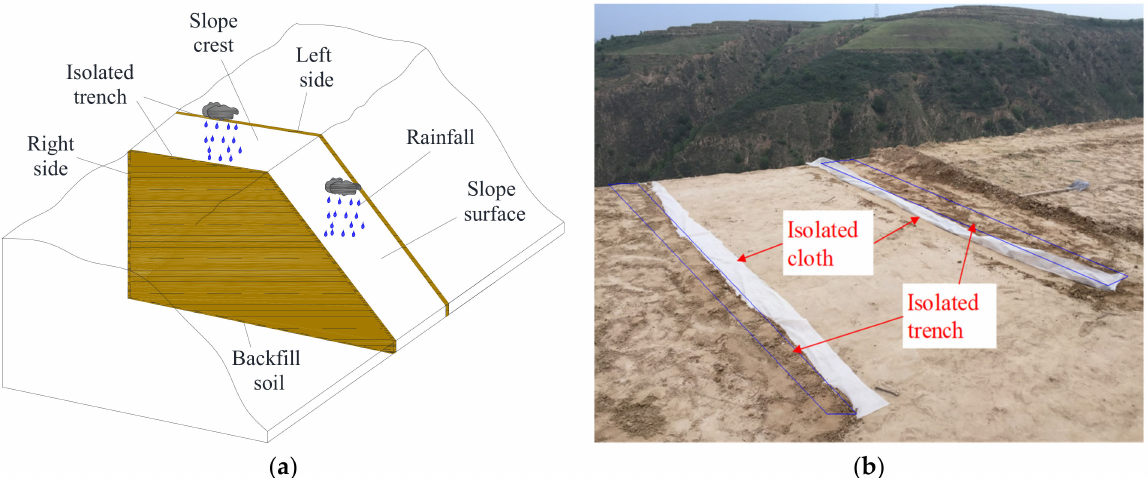
Figure 1. Treatment measure of deep-buried isolated trench. ( a ) Schematic diagram of the isolated trench; ( b ) the slope crest after construction with isolated